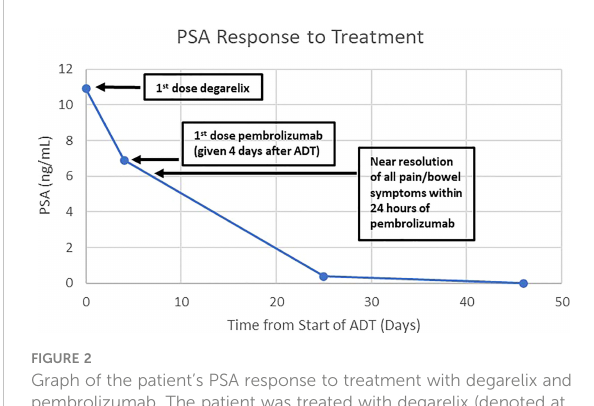
FIGURE 2 Graph of the patient ’ s PSA response to treatment with degarelix and pembrolizumab. The patient was treated with degarelix (denoted at Day 0) when his PSA was 10.92 ng/mL. Four days later, he was given pembrolizumab when his PSA was 6.9 ng/mL. His symptoms from the prostate mass largely resolved within 24 hours of the fi rst dose of pembrolizumab. The PSA became undetectable at day 46 from start of